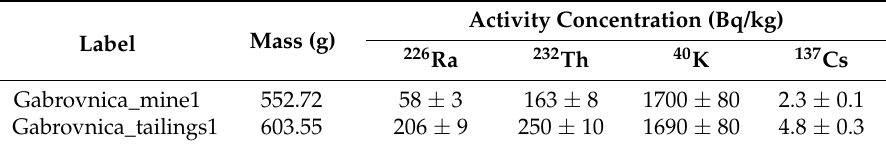
Table 3. Radioactivity of characteristic samples from the Gabrovnica mine area.